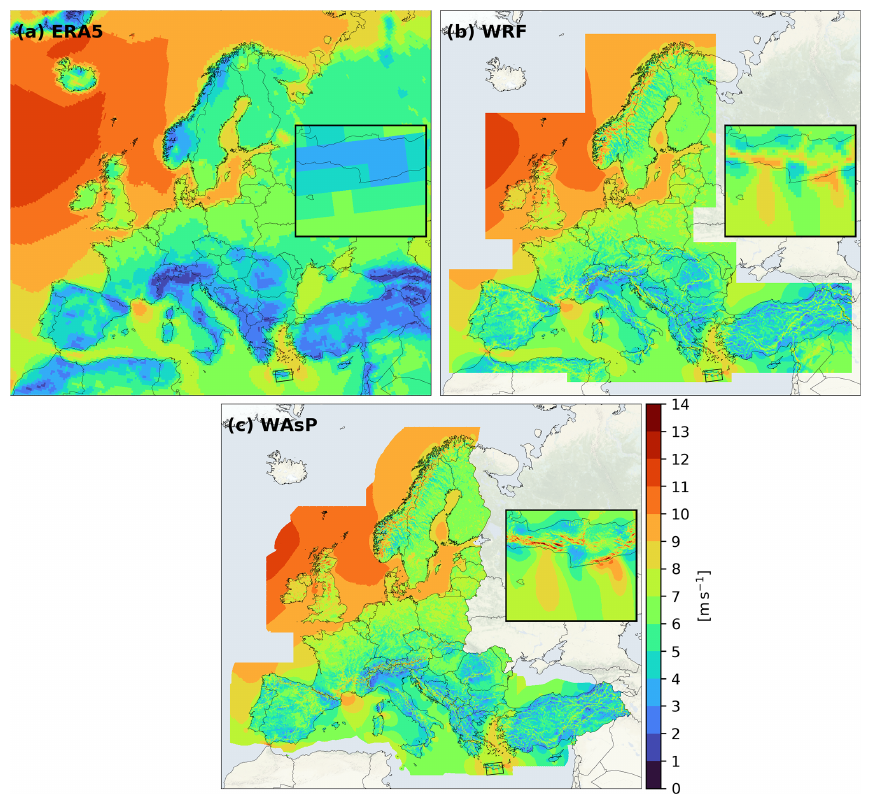
Figure 6. (a) ERA5, (b) WRF, and (c) WAsP mean wind speed at 100ma.g.l. averaged over the full 30-year period (1989–2018). The zoom-in shows the results for the island of Crete. Additional details can be seen on the NEWA wind atlas website https://map.neweuropeanwindatlas. eu/ (last access: 20 October 2020). The map background is the stamen terrain-background from http://maps.stamen.com/terrain-background (last access: 20 October 2020) – © OpenStreetMap contributors 2020. Distributed under a Creative Commons BY-SA